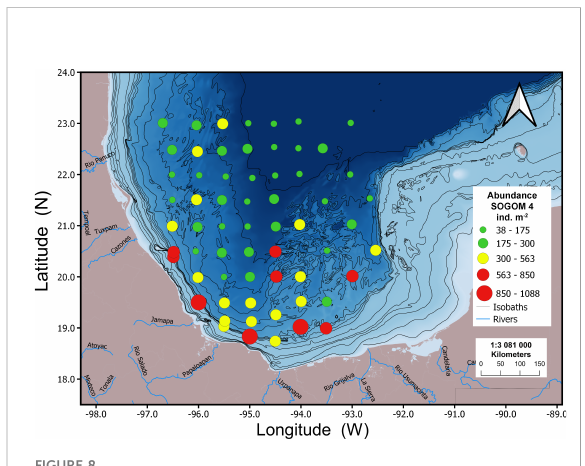
FIGURE 8 Geographic distribution of macrofauna abundance values for SOGOM